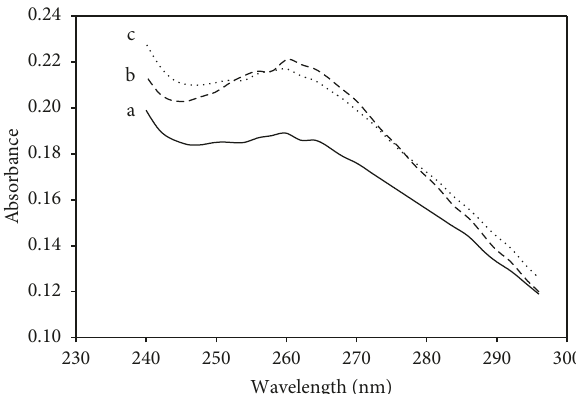
Figure 2: UV-visible absorption spectrum of aqueous solution of adenine at pH 7.0: (a) 1